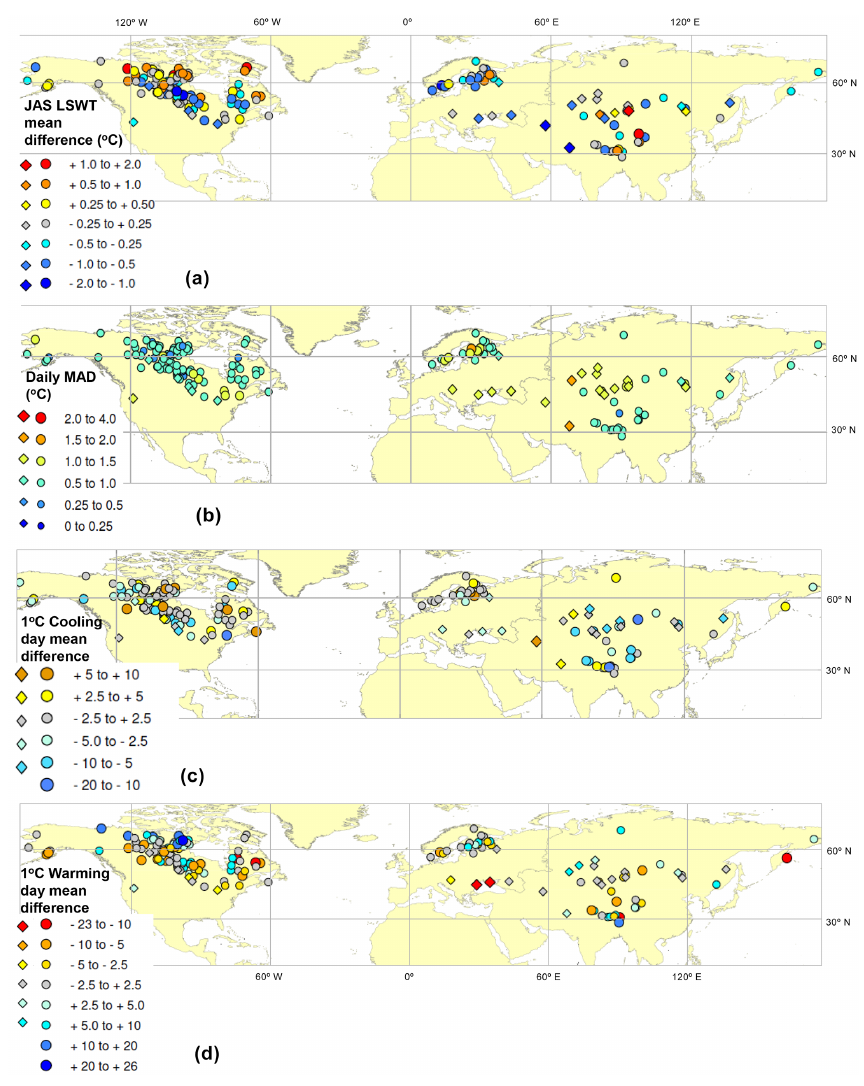
Figure 12. Tuning metric mean differences between modelled and observed LSWTs for all 160 lakes with seasonal ice-cover. The results for the 25 lakes tuned with modified tuning approach are marked by diamond symbols (a) July–August–September (JAS) LSWT mean